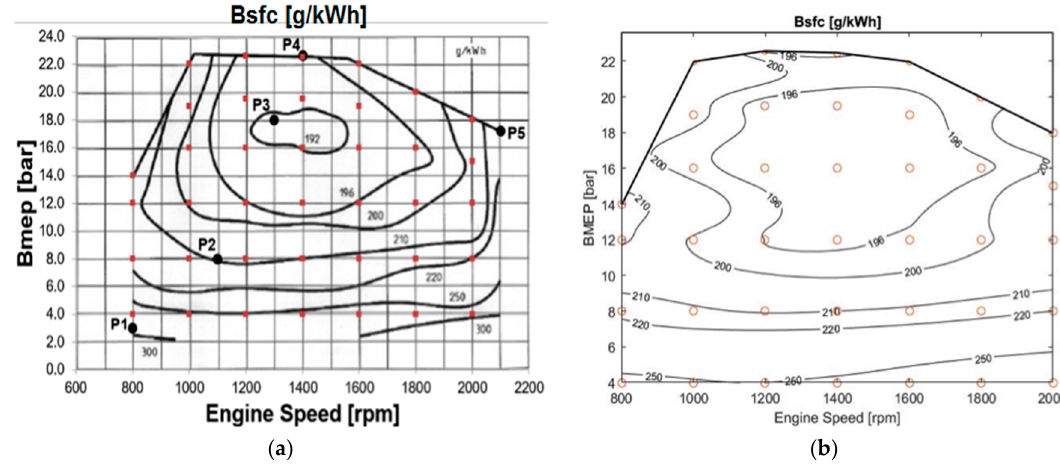
Figure 1. Selected operating points for engine model calibration: ( a ) BSFC map of base engine indicating five major points of engine operation i.e., P1, P2, P3, P4 and P5; ( b ) BSFC map of simulated engine.